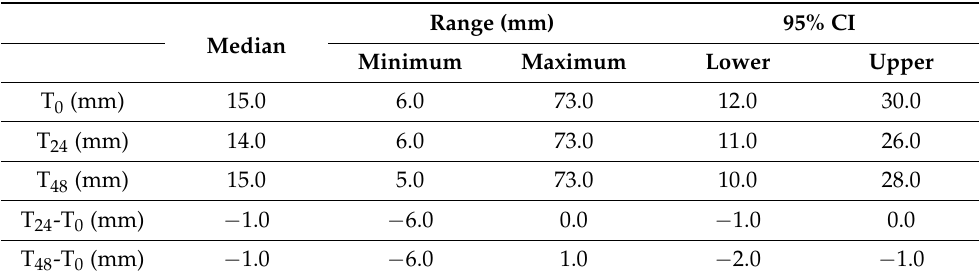
Table 2. Median tumor size and absolute shrinkage between time points.